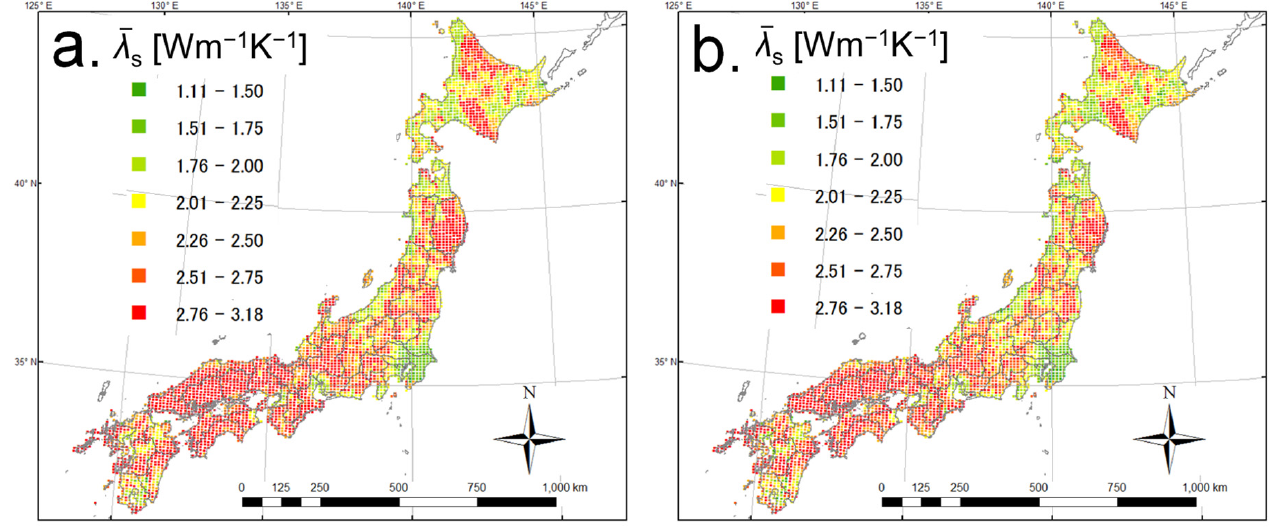
Figure 4. The 10 km gridded cell estimates of ground thermal conductivity at depths of 50 m ( a ) and 150 m ( b ).